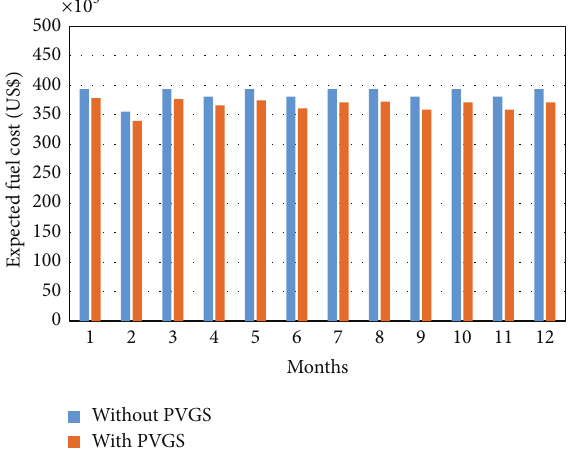
Figure 15: Monthly fuel cost with and without PVGS.